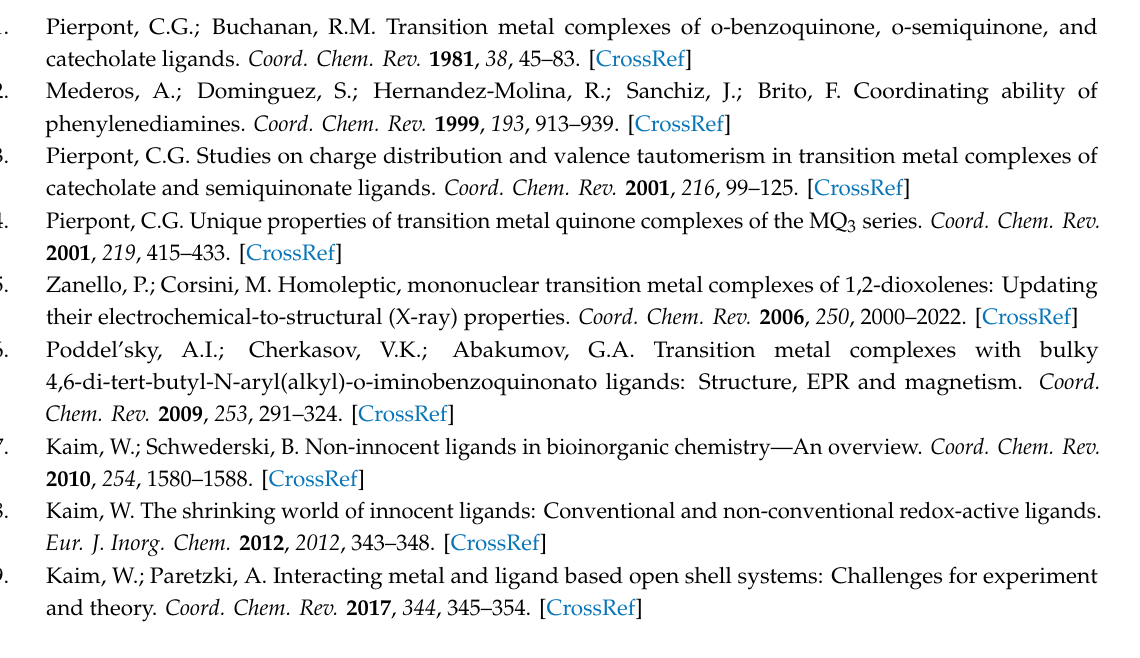
Table S2: The selected bond lengths for L1, Table S3: The selected bond lengths for 1, Figure S9: The intermolecular hydrogen bonds in crystals of L1, Figure S10: The order of complex 1 molecules in crystal cell with the indication of intermolecular hydrogen bonding, Figure S11: The CVs of compound L1 (CH2Cl2), Figure S12: the CV of the electrolysis products of compound L1, Figure S13: The CVs of compound 1 (CH3CN), Figure S14: The X-band EPR spectrum of the mixture “L1 + PbO2”. CCDC 1978538 (L1) and 1978539 (1) contain the supplementary crystallographic data for this paper. These data can be obtained free of charge from The Cambridge Crystallographic Data Centre via www.ccdc.cam.ac.uk / data_request /